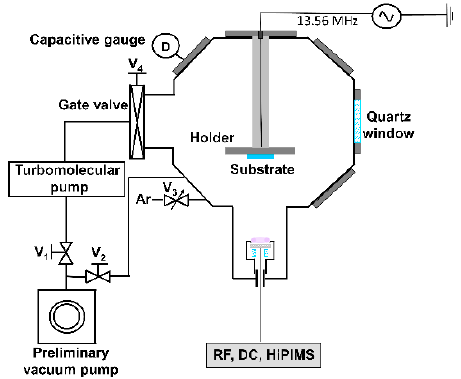
Figure 1. Experimental set-up of the magnetron sputtering deposition system.